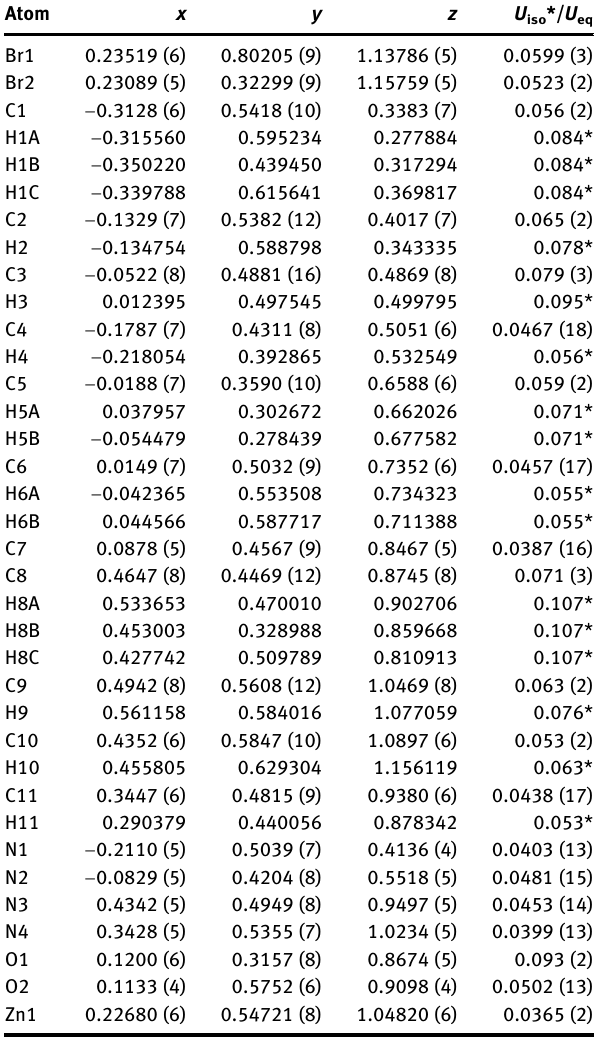
Table  : Fractional atomic coordinates and isotropic or equivalent isotropic displacement parameters (Å 